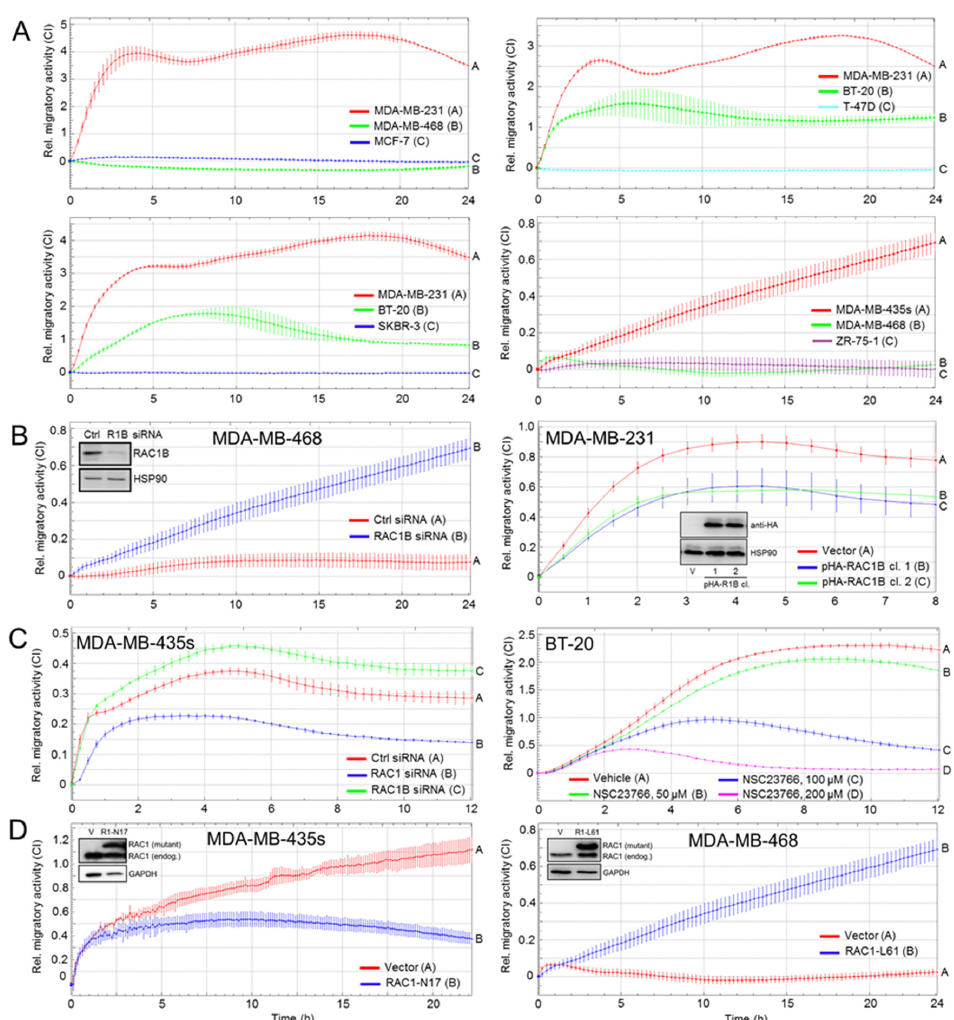
Figure 2. Real-time measurement of cell migration in established BC cell lines representing different histomorphological and transcriptional subtypes. ( A ) The indicated cell lines were subjected to real-time measurement of cell migration (chemokinesis setup) on an xCELLigence platform. Each graph shows the mean ± SD of 3–4 wells per cell line and is representative of three assays. ( B ) Left-hand graph, MDA-MB-468 cells were transfected with irrelevant control (Ctrl) siRNA or siRNA directed against exon 3b of RAC1 (R1B). Successful knockdown of RAC1B was verified by immunoblotting of RAC1B with HSP90 as a loading control (inset). Right-hand graph, MDA-MB-231 cells stably expressing either empty vector (V) or HA-tagged RAC1B (two individual clones (cl.), verified with an anti-HA antibody, clone 12CA5, Roche, inset) were subjected to xCELLigence assay. Data (mean ± SD of 4 wells) are from a representative assay. ( C ) Left-hand graph, MDA-MB-435s were transfected with Ctrl siRNA, RAC1 siRNA, or RAC1B siRNA as Ctrl as outlined in subfigure ( B ). Successful knockdown of RAC1 was verified by immunoblotting (not shown). Right-hand graph, BT-20 cells were left untreated or treated with the indicated concentrations of NSC23766 during the migration assay. ( D ) MDA-MB-435s (left-hand graph) or MDA-MB-468 (right-hand graph) cells were transfected with empty vector and either RAC1-N17 or RAC1-L61, respectively, and 48 h later subjected to measurement of migratory activities. Data are the mean ± SD of 4 wells and are representative of three assays. Overexpression of the RAC1 mutants was verified by RAC1 immunoblotting (insets); endog., endogenous. 4. Discussion We have previously shown that knockdown of exon 3b of RAC1 , which specifically prevents the generation of RAC1B but not RAC1 protein, enhanced spontaneous